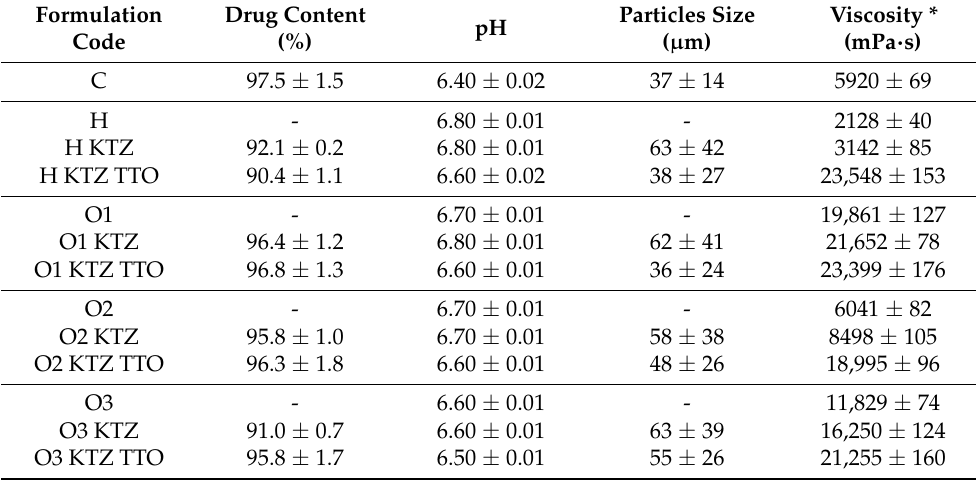
Table 3. Drug content, pH, particle size, and viscosity of prepared PLU ® F-127 hydrogels and